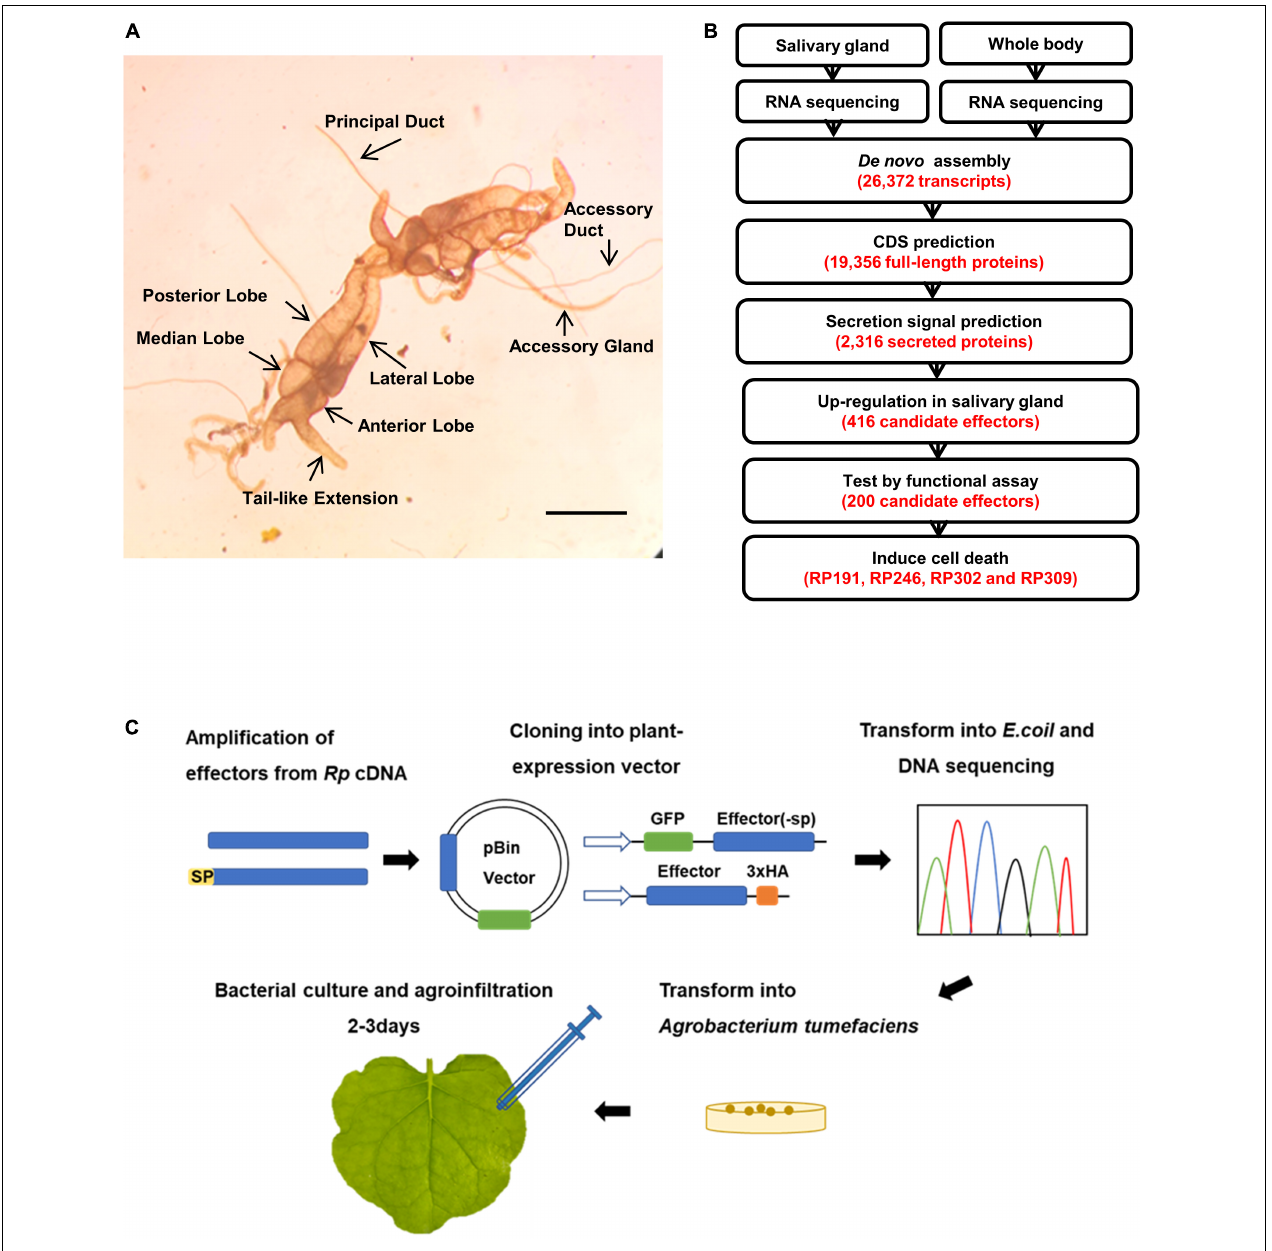
FIGURE 2 | Sequencing of R. pedestris salary gland transcriptome and prediction of candidate effectors. (A) The salivary gland structure of R. pedestris . Bar = 5 mm. (B) Bioinformatics pipeline for the identification of candidate effectors from R. pedestris salivary gland. (C) Flow chart of functional analyses of candidate effectors. Rp, R. pedestris